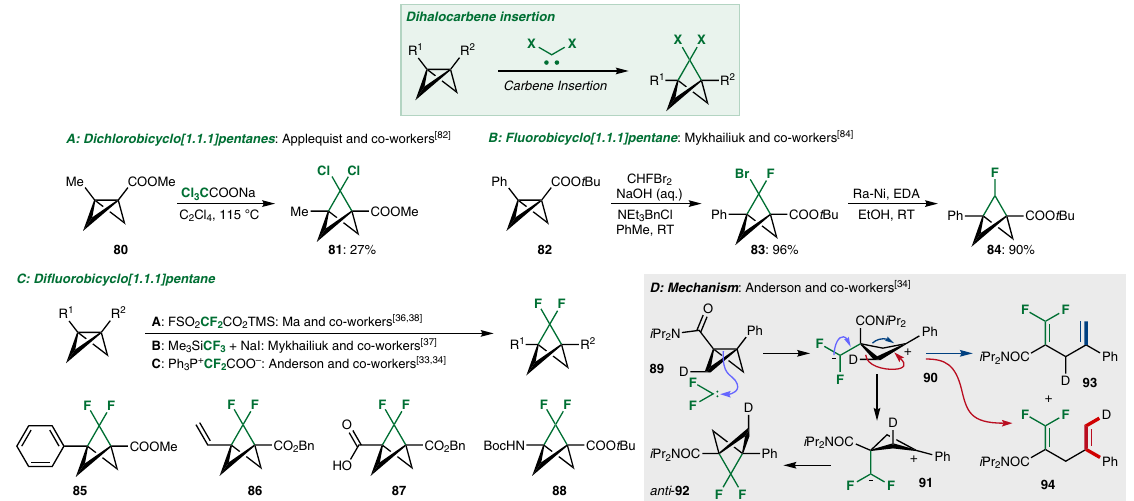
Fig. 4 Carbene insertions into BCBs to give halogenated BCPs. A Insertion of dichlorocarbene into bicyclobutanes. B Insertion of bromo fl uorocarbenes radicals into bicyclobutanes and the selective debromination to give mono fl uorinated bicyclopentanes. C Insertion of di fl uorocarbenes into bicyclobutanes along with functional group tolerance and downstream targets from these products. D Mechanistic investigations into the carbene insertion reaction by Anderson and co-workers which support a stepwise insertion mechanism. EDA ethylenediamine, TMS trimethylsilyl, Boc tert